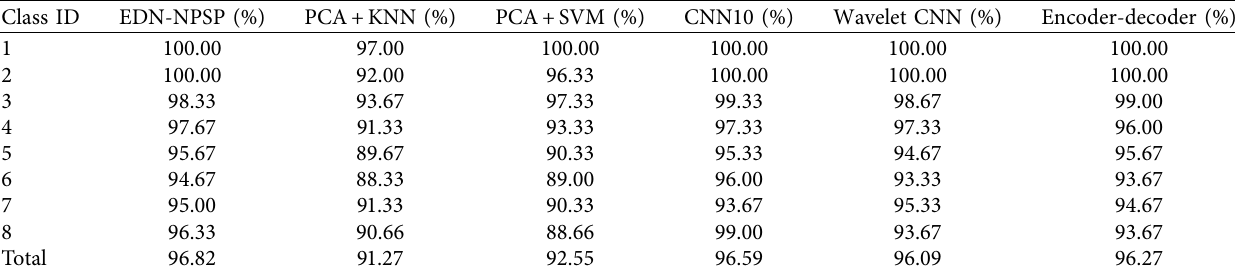
Table 4: Accuracy comparison of fault prediction and diagnosis